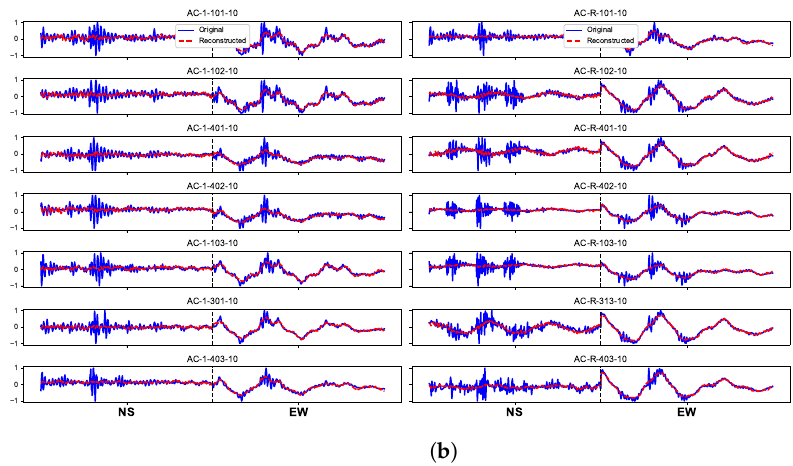
Figure 5. Reconstructed signals: ( a ) Seq2Seq model (LSTM architecture); and ( b ) baseline model.